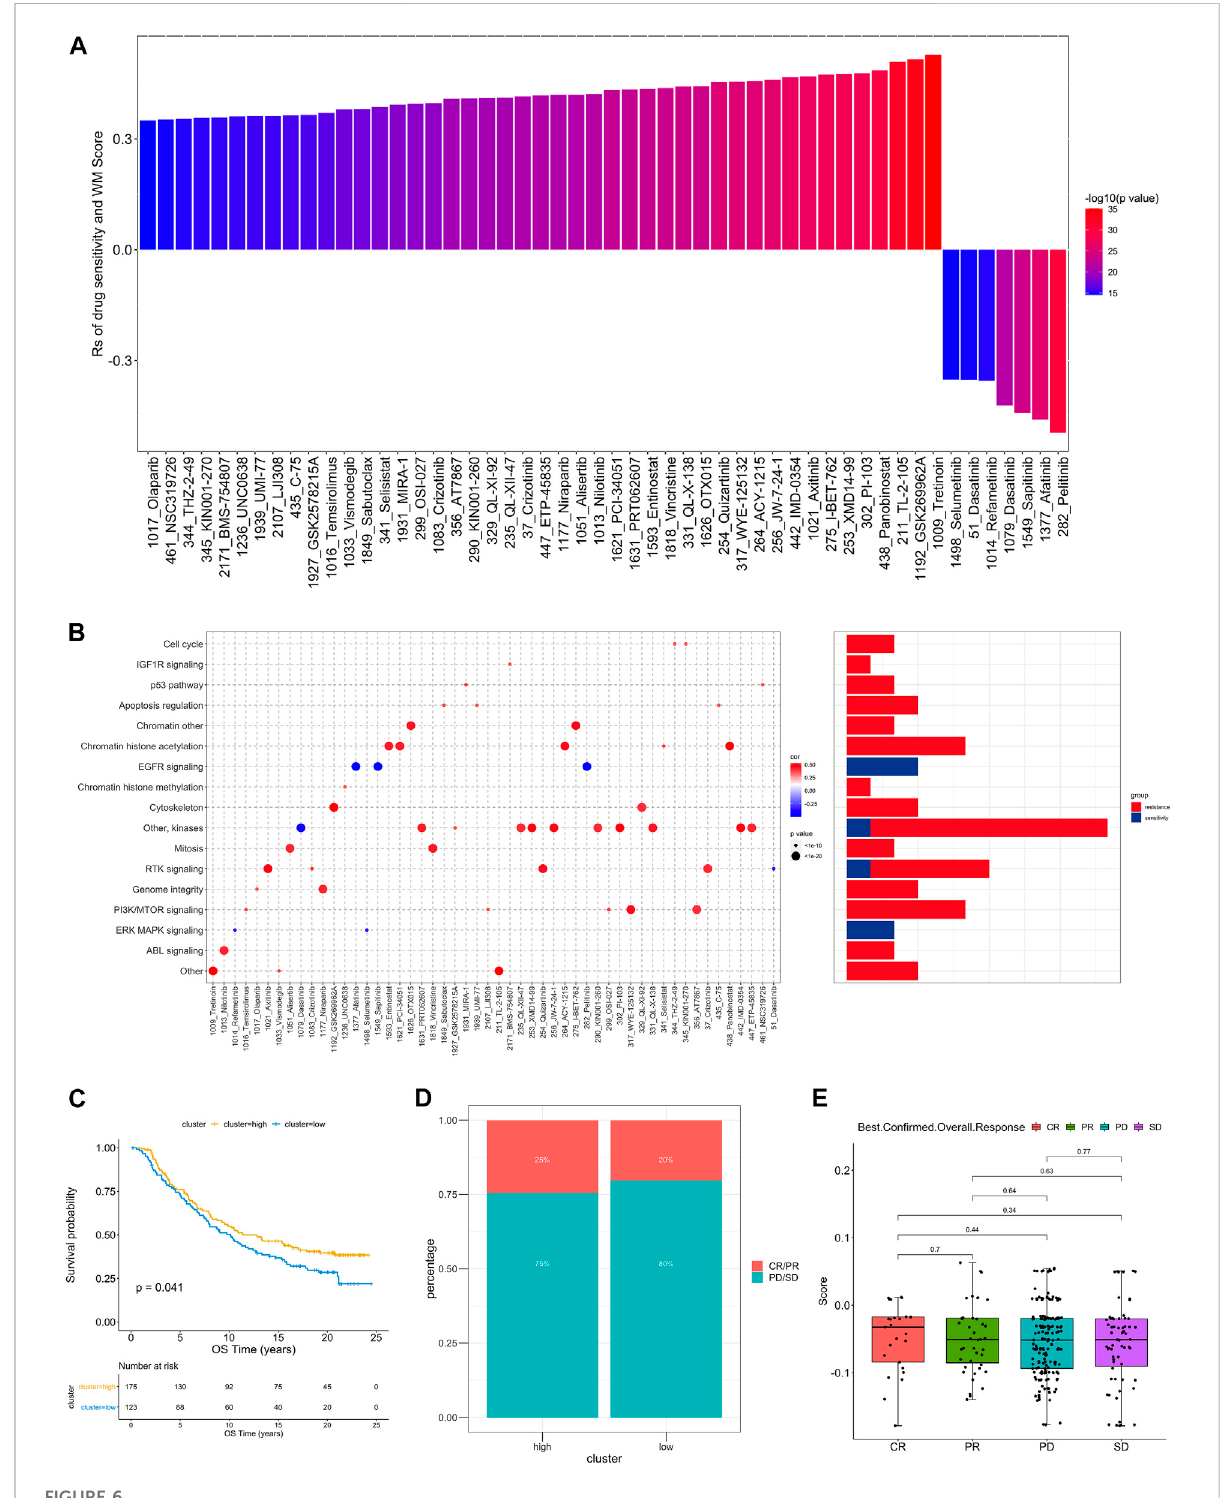
FIGURE 6 The relationship between WM_Score and drug sensitivity and ef fi cacy of immunotherapy. (A) The correlation between WM_Score and drug sensitivity evaluated by the Spearman analysis. Each column represents a drug. The color of the column indicates the signi fi cance of the correlation. The height of the column indicates the correlation, indicates that WM_Score related to drug resistance (Rs > 0) or drug sensitive (Rs < 0) to WM_ Score. (B) Signaling pathways targeted by drugs that are resistant (red) or sensitivity (blue) to the WM_Score. Drug names are listed on the